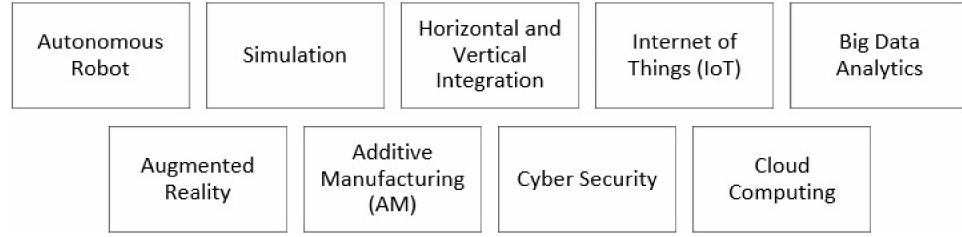
Figure 1. Nine pillars of Industry